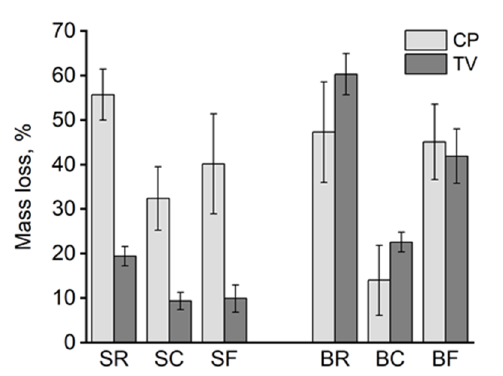
Figure 3. Mass loss of spruce and birch (%) samples exposed to decay fungi C. puteana (CP) and T. versicolor (TV). Error bars for 95% confidence interval. R = unmodified; C = contact charred; F = flame charred; S = spruce; B = birch.